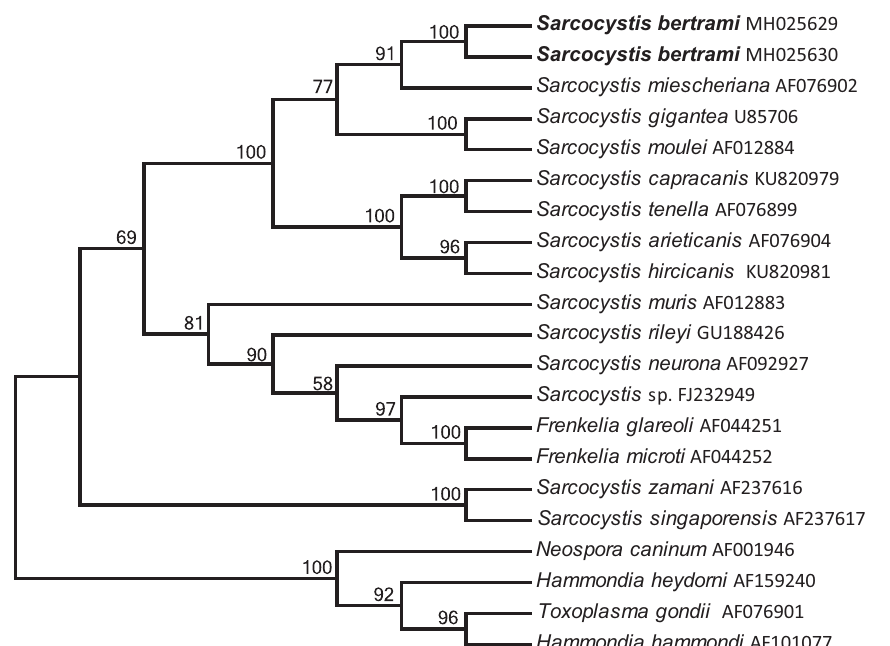
Figure 3. Phylogenetic tree based on 28S rDNA gene sequences. The tree was built using the maximum parsimony method with the Tree- Bisection-Regrafting algorithm. The analysis involved 21 nucleotide sequences (GenBank accession numbers behind the taxon names) and a total of 3680 positions in the fi nal dataset. The values between the branches represent the bootstrap values per 1000 replicates, and values below 50% are not shown. The two new sequences of Sarcocystis bertrami (MH025629 and MH025630, shown in boldface) formed a clade with S. miescheriana from a pig, and Sarcocystis spp. from